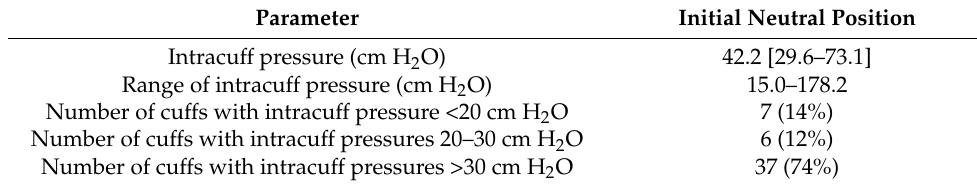
Table 2. Initial intracuff pressure in the neutral head position when the cuff pressure was set by pilot balloon palpation.